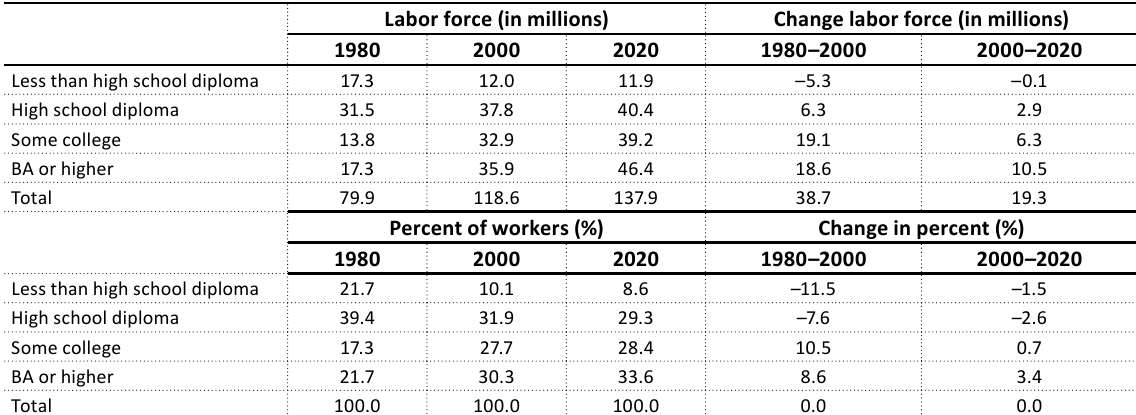
Table 1. Actual and projected supply of workers, aged 25+ by educational attainment